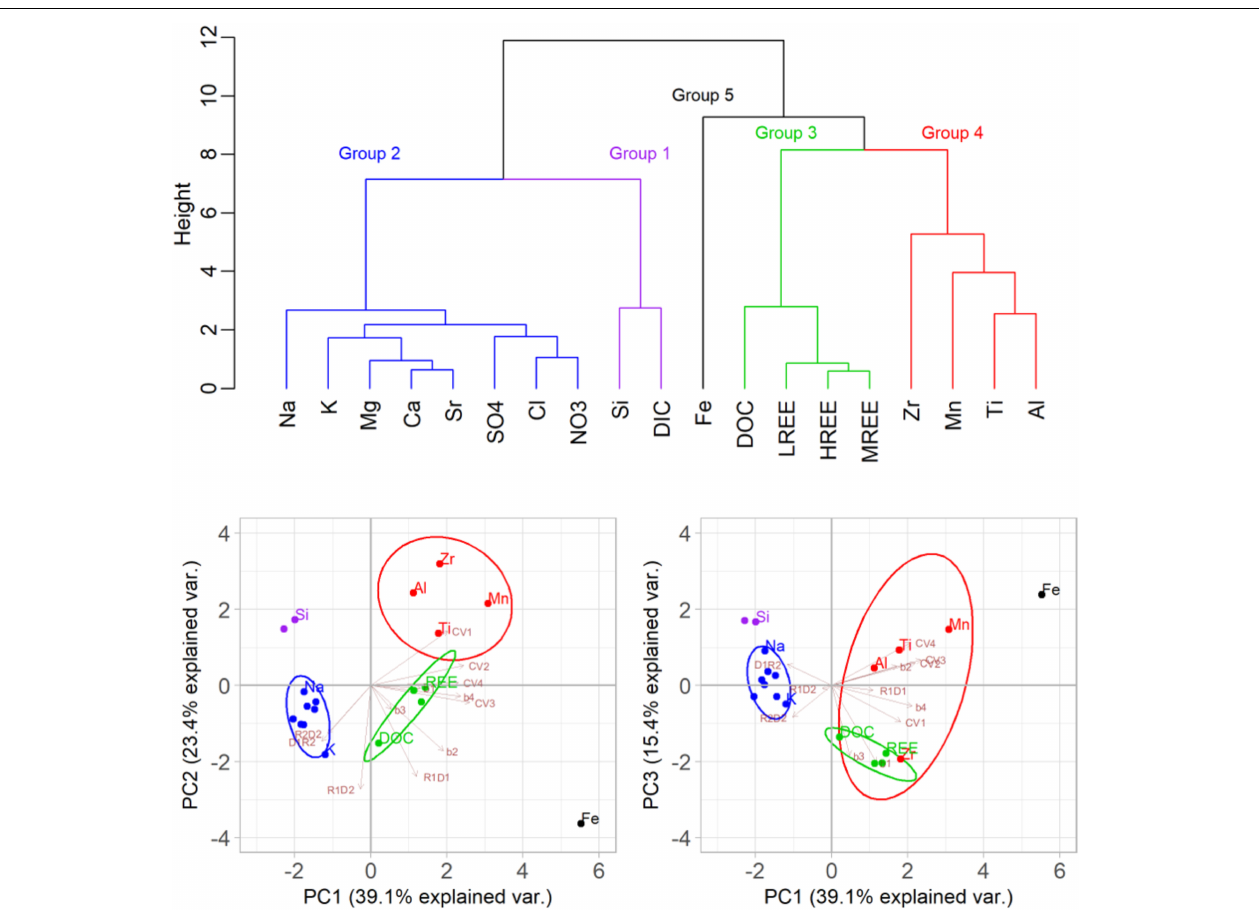
FIGURE 6 | Cluster dendogram (top) with colors representing the five distinct solute groups identified and where Y -axis Height is the value of the criterion associated with the clustering method. Moving along the clustering tree from bottom to top, each leaf (group) fuses into another. Fusion at larger height represents larger distance between the groups. Biplots of the principle component (PC) pairs (bottom) showing PCs 1 and 2 (bottom left) and PCs 1 and 3 (bottom right) . Loadings of the exponent a (equation 1), the coeficients of variance (CV C /CV Q ), and the hysteresis indices between pairs of limbs (R for rise and D for falling limbs), are shown in brown arrows. Ellipsoid probability (95%) encapsulates the